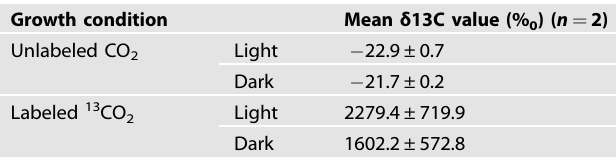
Table 2. Carbon isotope values of strain WC8-2 cells in growth experiments using labeled 13 CO 2 versus unlabeled CO 2 . Growth condition